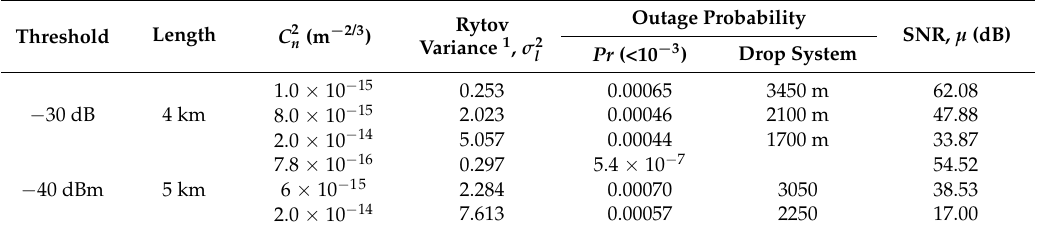
Table 2. Outage probability for an FSO link with the parameters of Table 1.